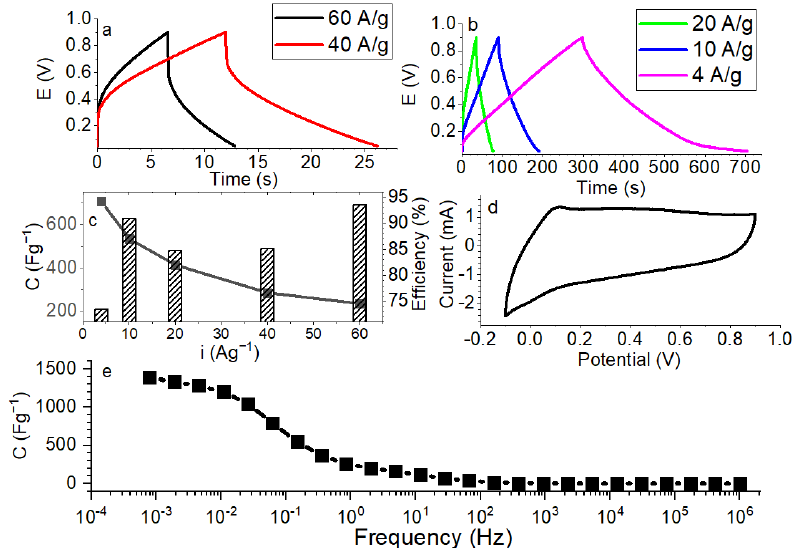
Figure 10. ( a ) Charge–discharge curves of TiON/C-CNF1 fabric at 40 Ag − 1 and 60 Ag − 1 , from 0.05 V to 0.9 V, ( b ) charge–discharge curves of TiON/C-CNF1 fabric at 4 Ag − 1 , 10 Ag − 1 , and 20 Ag − 1 , from 0.05 V to 0.9 V, ( c ) specific capacitances and coulombic efficiency of TiON/C-CNF1 fabric for different current densities from charge–discharge curves, ( d ) cyclic voltammetry (CV) at a scan rate of 10 mV/s, and ( e ) specific capacitance of TiON/C-CNF1 fabric determined with electrochemical impedance spectroscopy (EIS).